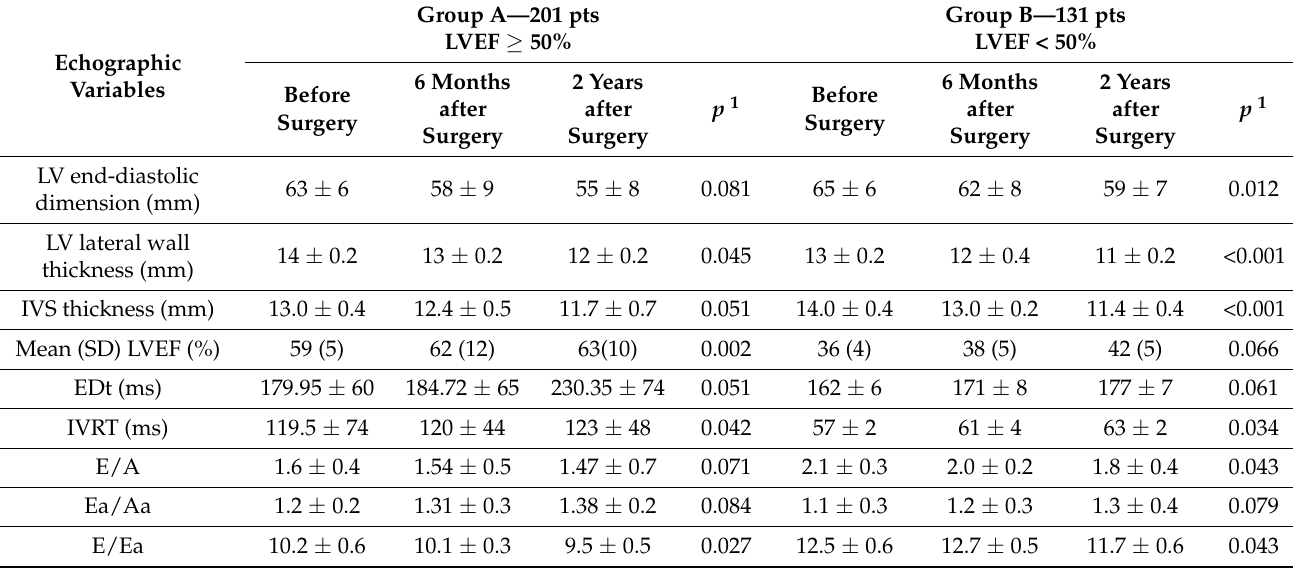
Table 2. Comparison of preoperative and postoperative echocardiographic